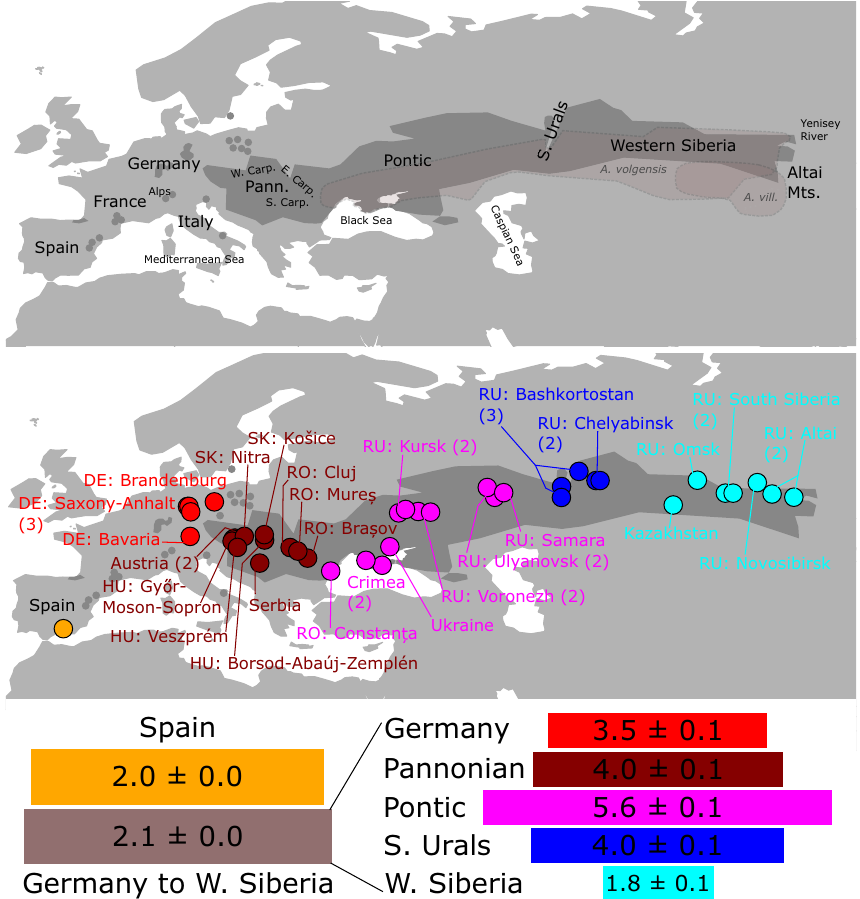
Figure 1. Top: Map of Europe and Middle Asia showing the approximate distribution ranges of Adonis vernalis (dark grey), A. villosa and A. volgensis 21,22 and important geographical designations used in this study (Carp.— Carpathians; Pann.—Pannonian). Following standard biogeographical literature, we use the term Middle Asia to refer to the region between the Ural Mountains and the Altai Mountains (corresponding to Western Siberia), and the term Central Asia to refer to the region east of the Altai Mountains 1 . Middle: Sampled populations of A. vernalis in the Euro-Siberian region. Populations are divided into colour-coded geographic groups (Supplementary Table S4 online). Two-letter abbreviations are ISO alpha-2 country codes. The numbers in parentheses indicate the number of populations (if more than one). Bottom: Private allelic richness (pAr) in two comparisons, left Spain versus all other populations (value = pAr × 10), right geographic groups from Germany to Western Siberia (excluding the Spanish population; value = pAr × 100). Values are the mean ± standard error over 8,539 unlinked SNPs calculated from GBS data. The map was created in R v4.2.1 (https:// www.R- proje ct. org/) with the package rworldmap v1.3–6 (https:// rdocu menta tion. org/ packa ges/ rworl dmap/ versi ons/1. 3-6) and edited in Inkscape v0.92 (https:// inksc ape.